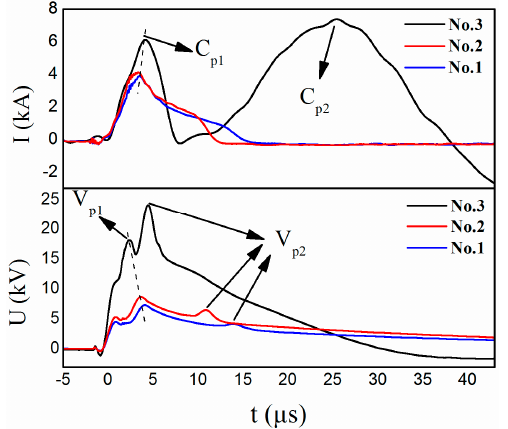
Figure 7. Typical current and voltage plots of tests No. 1–3 tests. In the plots, the first and second peaks of discharge current are labelled as Cp1 and Cp2, respectively. The first and second peaks of discharge voltage are labelled as Vp1 and Vp2, respectively.